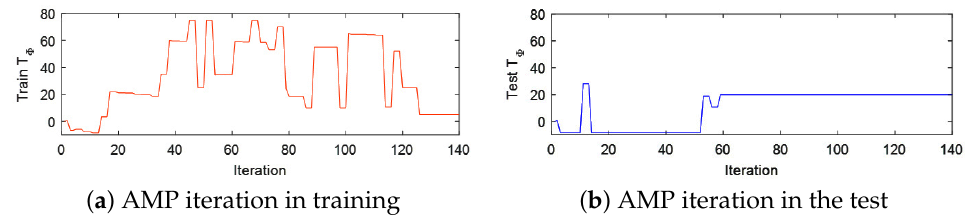
Figure 4. T Φ dynamic during AMP iterating. It indicts the process of optimal decision making for the neighbourhood by MAP. If the change rate of T Φ closes to zero, MAP obtains the OEAN.